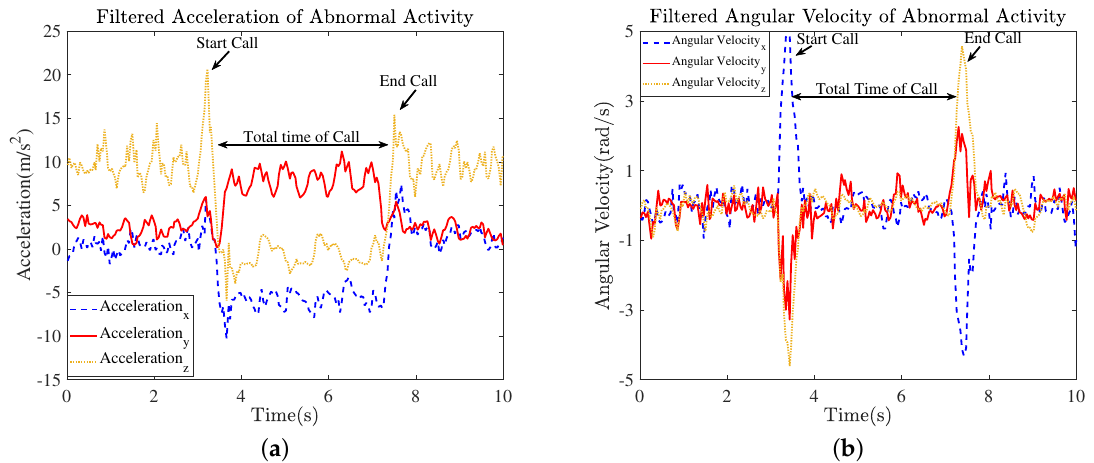
Figure 9. Signals of accelerometers and gyroscope sensors during abnormal activity: ( a ) filtered bodily acceleration and ( b ) filtered angular velocity during abnormal